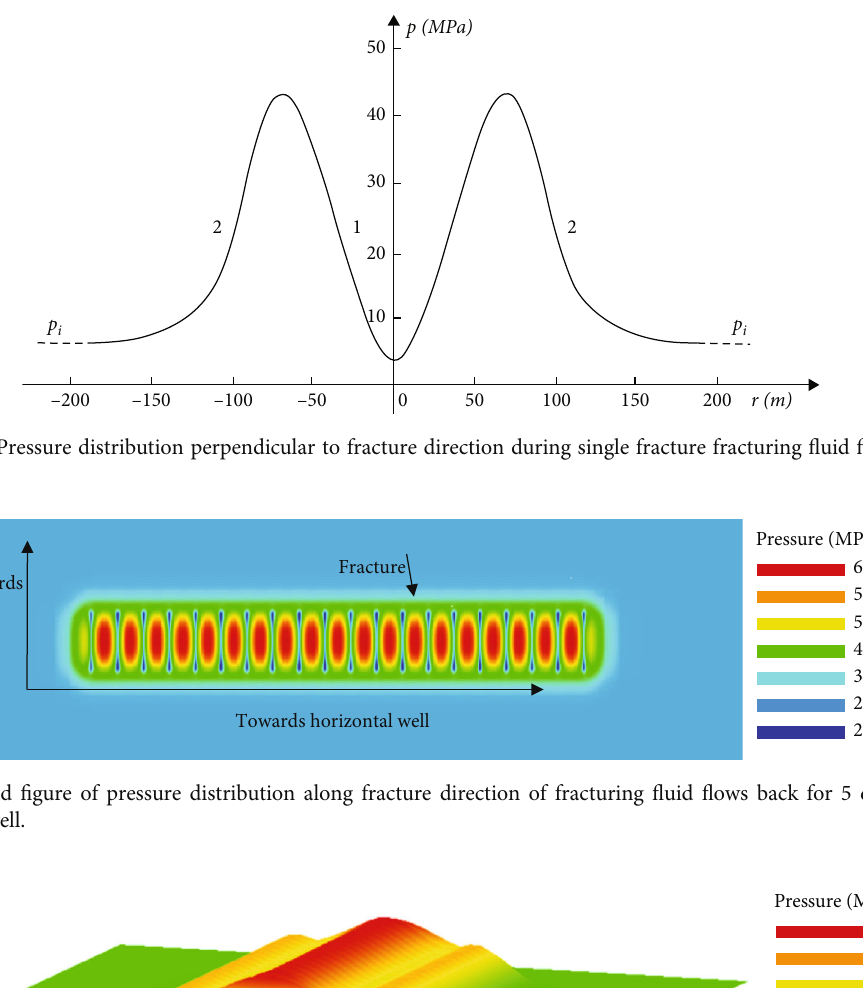
Figure 6: Double pressure funnels phenomenon of pressure distribution perpendicular to the fracture direction when a single fracture fl ows back for 5 days.